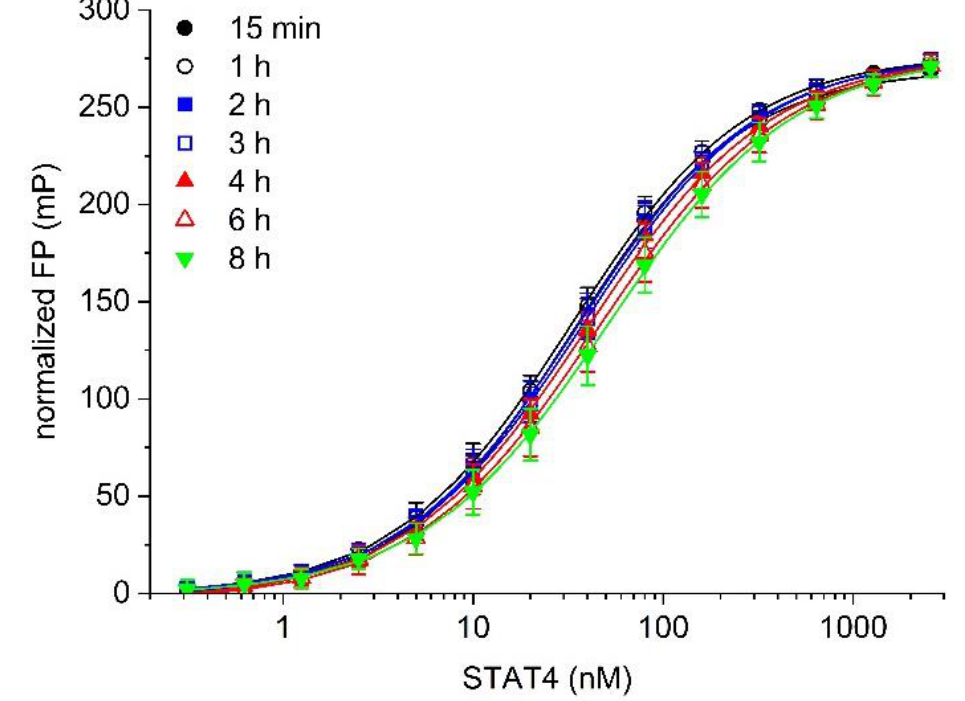
Figure 3. Temporal stability of binding of the probe 5-CF-GpYLPQNID to STAT4. In order to confirm the suitability of the STAT4 binding assay for use in competitive inhi- bition assays, the effect of increasing concentrations of the unlabelled peptide Ac-GpYLPQNID on binding between 5-CF-GpYLPQNID and STAT4 was assessed. Ac-GpYLPQNID inhibited the interaction between STAT4 and the fluorophore-labelled peptide with an IC 50 value of 0.49 ± 0.04 µ M (K i = 0.22 ± 0.02 µ M, Figure 4, Table 1). The reversibility of the interaction between 5-CF-GpYLPQNID and STAT4 is indicated by the near-complete (96%) inhibition at 40 µ M Ac-GpYLPQNID, with an extrapolated maximum inhibition of 98.4 ± 0.9% at infinite peptide concentrations. The STAT3 inhibitor peptide Ac-pYLPQTV-NH 2 [10,34] was 2.6-fold less active (IC 50 = 1.27 ± 0.10 µ M, K i = 0.60 ± 0.05 µ M). Weaker activities were observed for the STAT5 inhibitor peptide DTpYLVLDKWL [12] (IC 50 = 4.17 ± 0.13 µ M, K i = 1.99 ± 0.06 µ M) and the STAT1 inhibitor peptide GpYDKPHVL [26] (IC 50 = 31.4 ± 6.7 µ M, K i = 15.1 ± 3.2 µ M). The unlabelled peptide GpYEEIP, which binds to SH2 domains of Src [28] and Lck [29], in- hibited STAT4 only to a lesser extent (37 ± 4% inhibition at 40 µ M, the highest concentration tested). The Plk1-binding peptide MAGPMQSpTPLNGAKK [30] had no detectable inhibitory effect. Thus, the profile of inhibitory activities of the unlabelled peptides in the competitive inhibition assay (Figure 4, Table 1) closely correlates with the relative binding affinities of the corresponding fluorescein-labelled peptides in the direct binding assay (Figure 1a), indicating that the presence of the fluorophore does not alter the selectivity profile of the underlying peptide sequences.